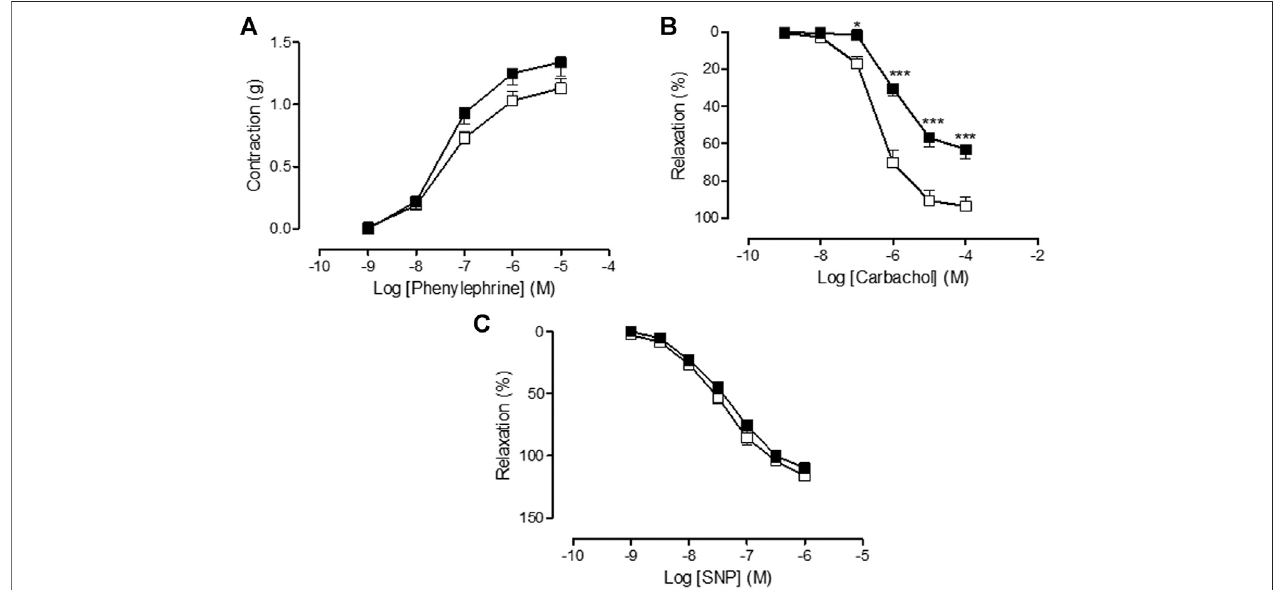
FIGURE 3 | (A) Concentration-response curve of phenylephrine (10 − 9 M – 10 − 5 M), (B) concentration-response curve of carbachol (10 − 9 M – 10 − 4 M), and (C) concentration-response curve of sodium nitroprusside (SNP) (10 − 9 M – 10 − 6 M) in isolated rat aorta rings from animals chronically treated with saline (saline treatment, white squares) or vincristine (vincristine treatment, black squares). Values are expressed as mean ± SEM, n (cid:2) 11 – 21 preparations per experimental group. A two-way ANOVA followed by the Bonferroni test was used for statistical analysis (*** p < 0.001, * p < 0.05, vincristine treatment vs. saline treatment).